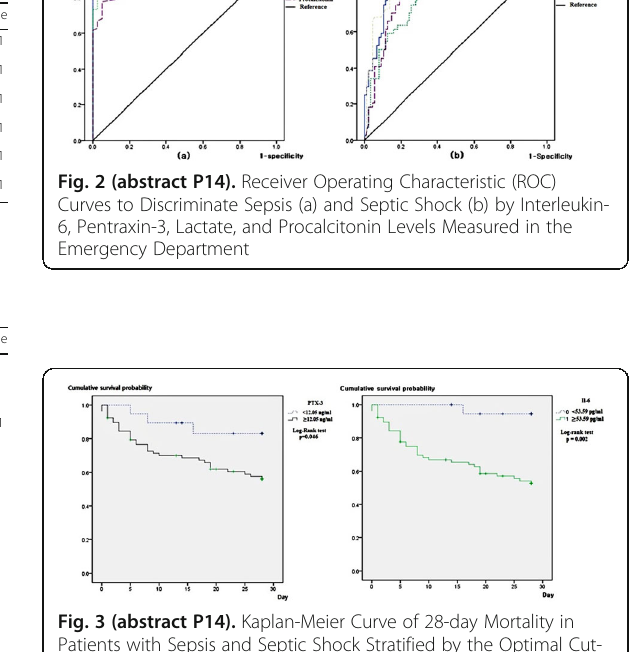
Table 2 (abstract P14). Diagnostic Value of Interleukin-6 (IL-6), Pentraxin-3 (PTX-3), and Procalcitonin (PCT) for Patients with Sepsis and